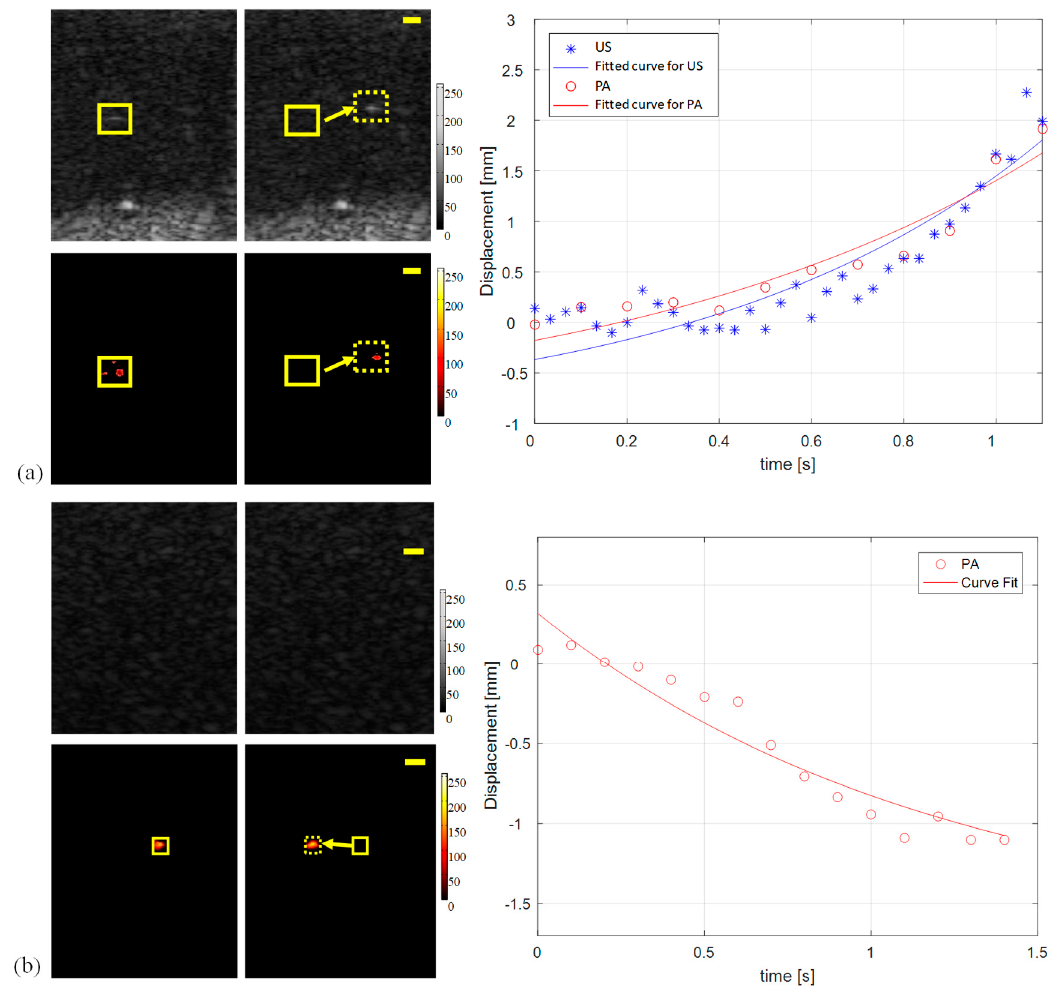
Figure 3. US and PA tracking results of a single 400 µm microrobot ( a ) and 100 µm microrobot ( b ) in motion. The imaging results indicated the PA imaging has higher sensitivity to detect the smaller microrobot, where the US was unable to track the object. The solid rectangles in the images demonstrate the start position of the microrobot, and the end positions were marked as dashed rectangles. The solid lines in the fitted curves estimate the motion of the microrobot. The scale bars are 1 mm. The color bar shows the image intensity.